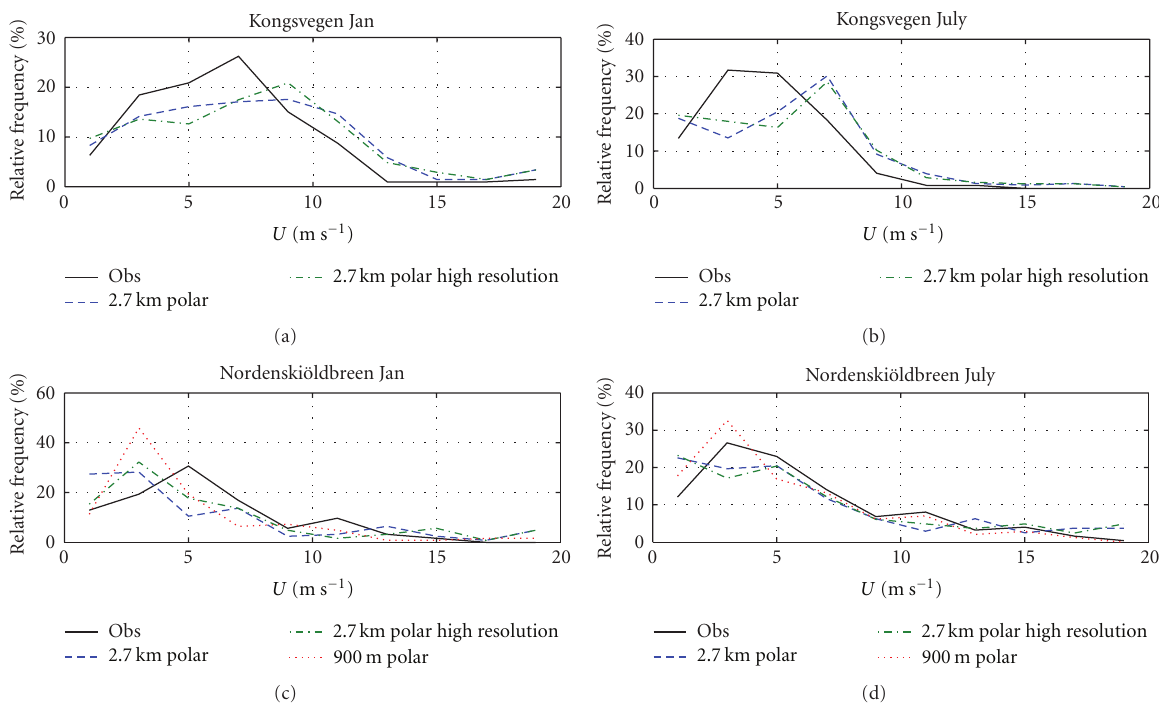
on validating the following surface variables: temperature, wind speed, specific humidity, and incoming short-wave and long-wave radiation. The WRF data are compared with observational data received from three automatic weather stations on Svalbard, Kongsvegen, Vestfonna, and Norden-